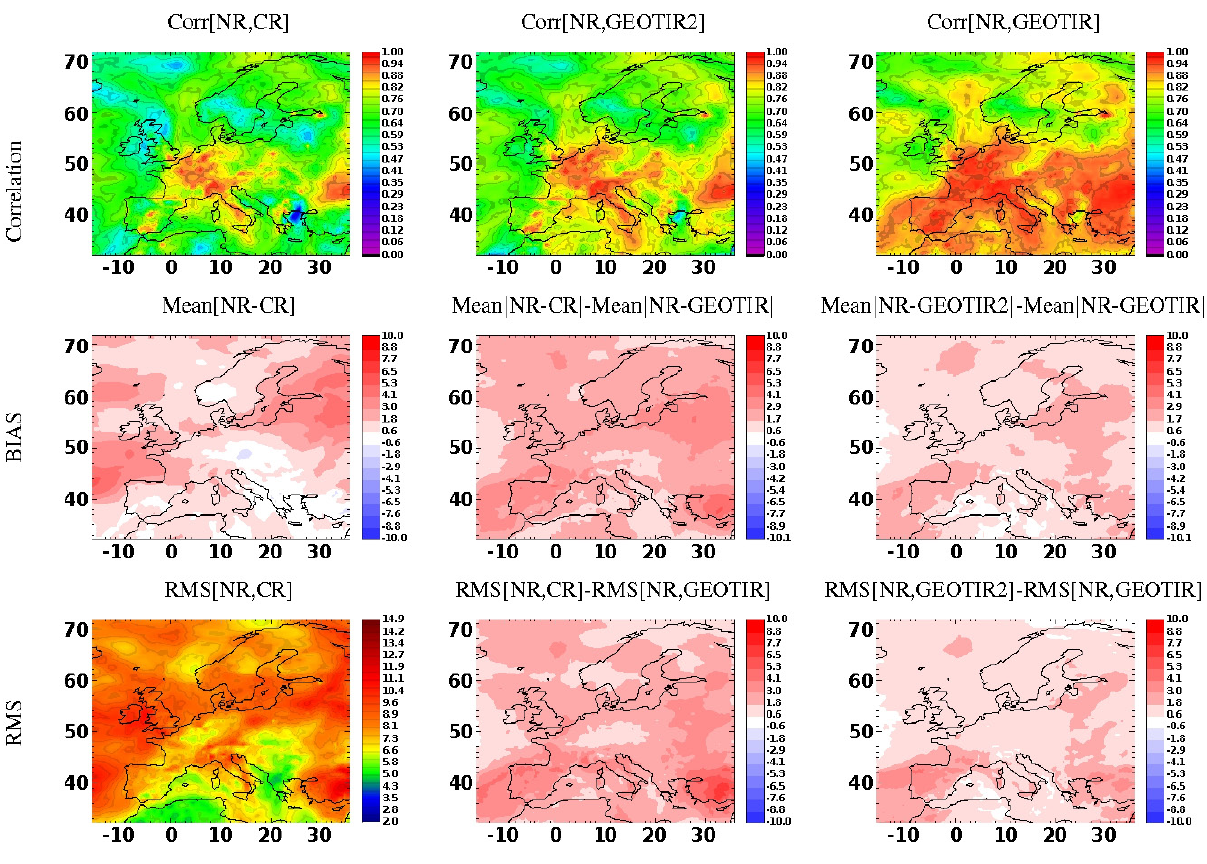
Fig. 10. Same as Fig. 9 (EXP3) but for